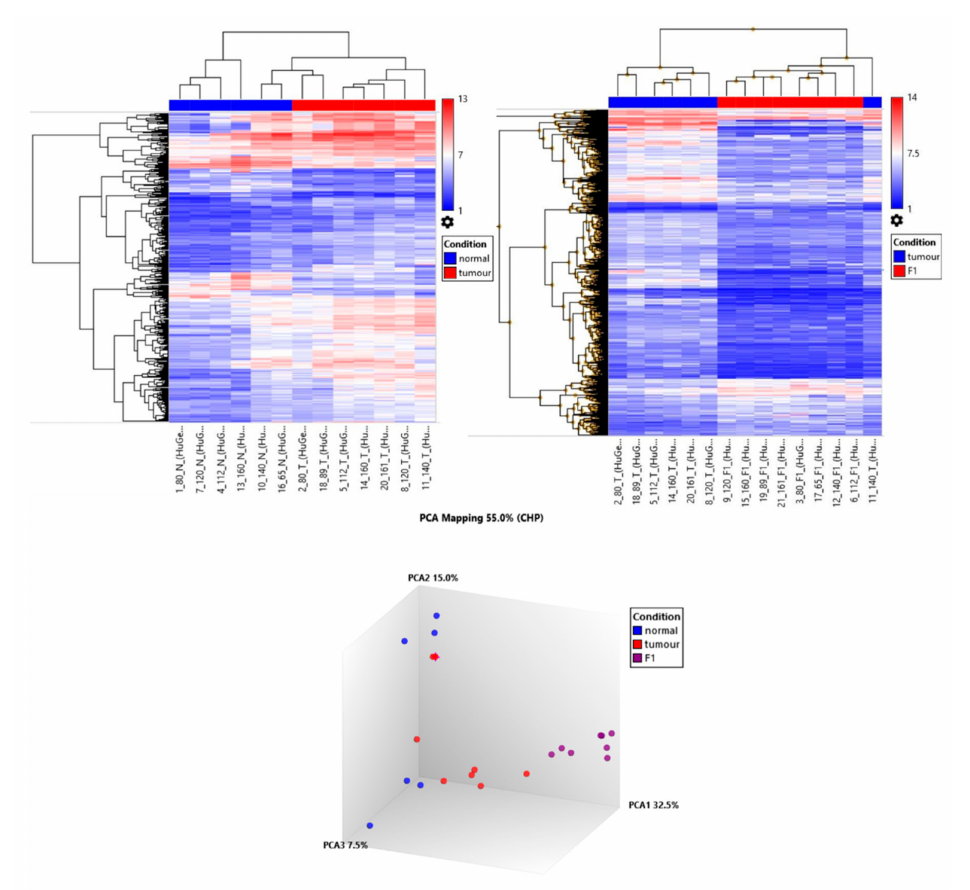
Figure 4. Hierarchical clustering and principle component analysis of adjacent normal tissue, patient tumour and PDX